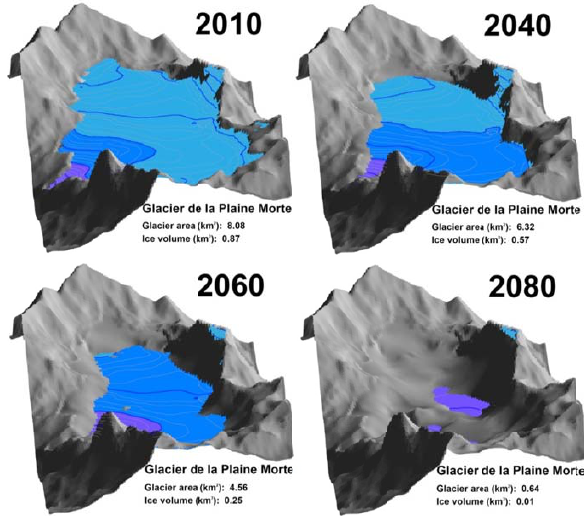
Fig. 10. Modeled future retreat of the Plaine Morte in 2010, 2040, 2060, and 2080. Colors indicate surface elevation bands of the 0: Modeled fu banfuture retreat t of the Plaine surface e elevation ds of the glac cier. The glac glacier. The glacier area and volume for each time slice are indi- panels. cated in the